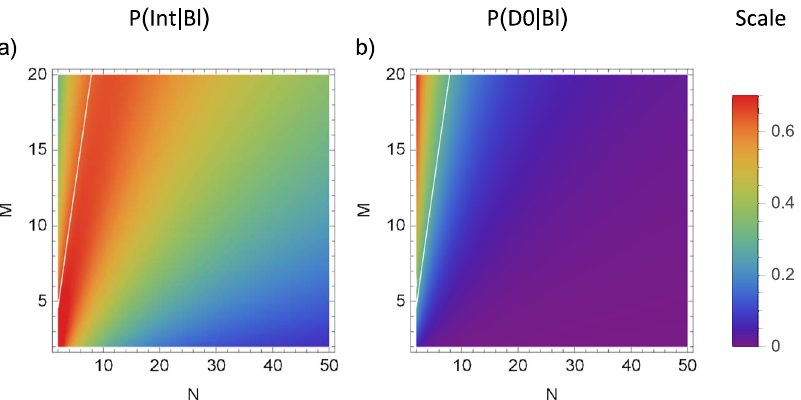
Fig. 3 Loss probabilities when the object blocks the path. Probability, when the object blocks the channel, of the photon: interacting with the object being imaged (P Int ) ( a ); or erroneously ending up in D 0 ( b ). We plot these for given numbers of outer ( M ) and inner ( N ) interferometer cycles. Note, the photon only goes via the object erroneously - in any case when D 1 clicks, the detection of the object will have been fully counterfactual. Further, both the interaction and erroneous- D 0 probabilities go to 0 as N goes to ∞